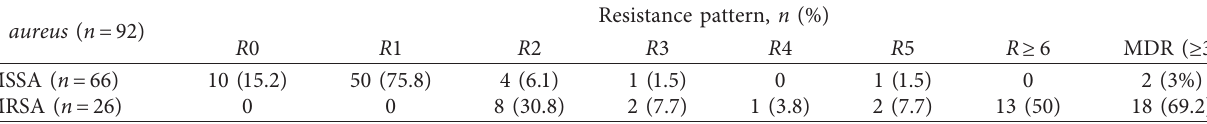
Table 3: MDR pattern of bacteria isolated from wound infection among patients attending Dessie Referral Hospital. S. aureus ( n � 92)